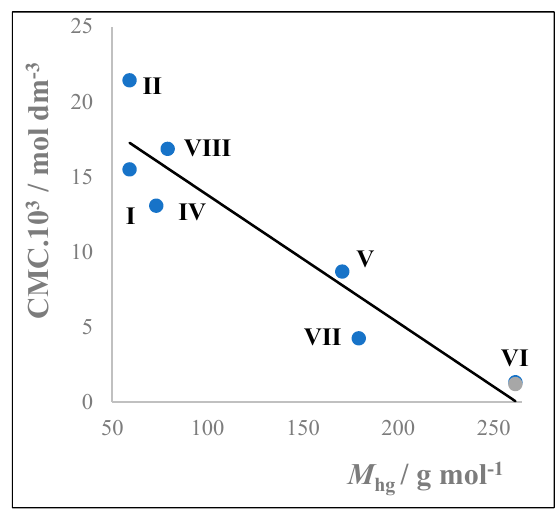
Figure 5. Influences of molar mass of hydrophilic groups ( M hg ) on micellization of surfactants at 25 °C . Surfactants III didodecyldimethylammonium chloride which creates vesicles and IX, X are anionic surfactants and are omitted.